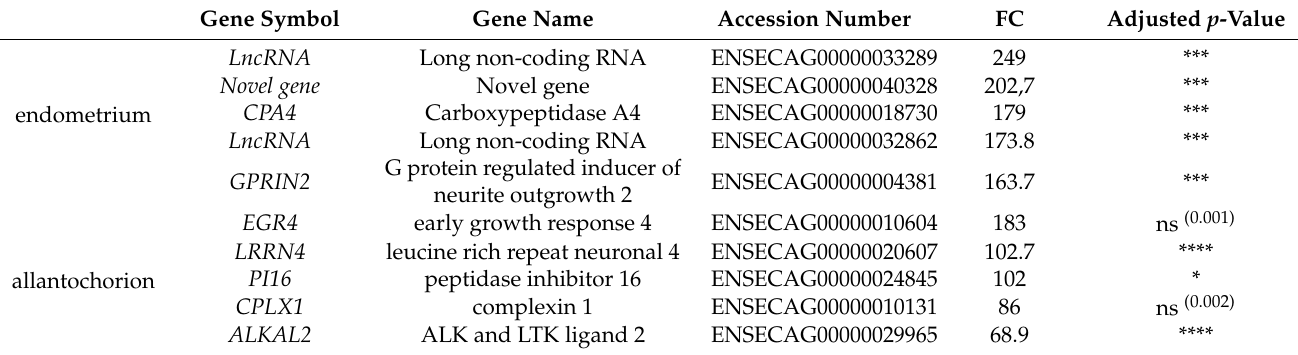
Table 1. Top five differentially expressed genes (DEGs) in the endometrium and in the allantochorion with their accession numbers, fold change (FC), and corresponding adjusted p